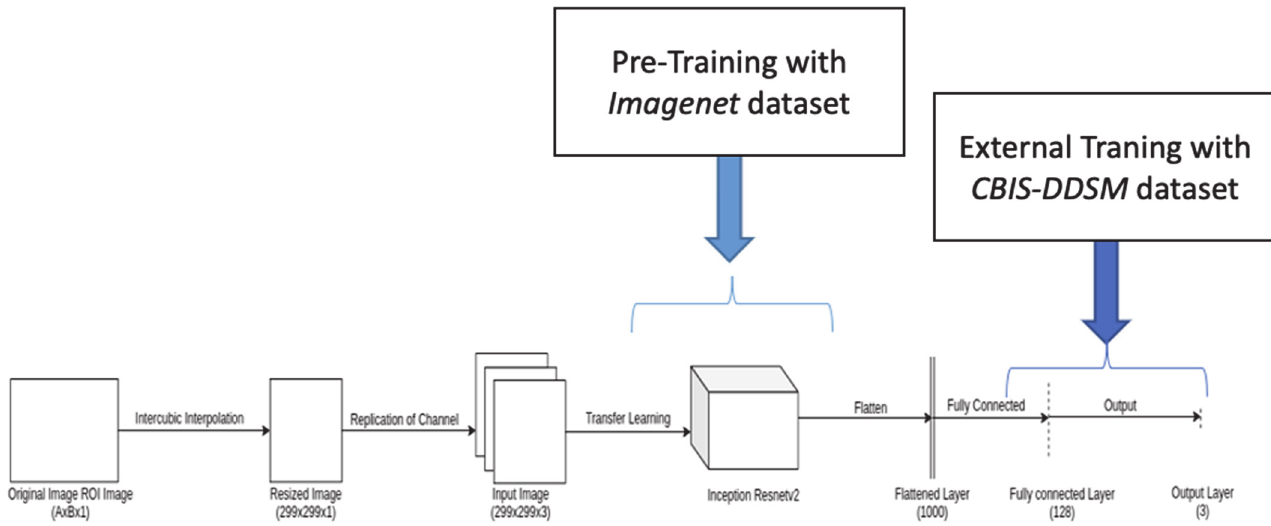
Figure 2. Proposed convolutional neural network architecture.